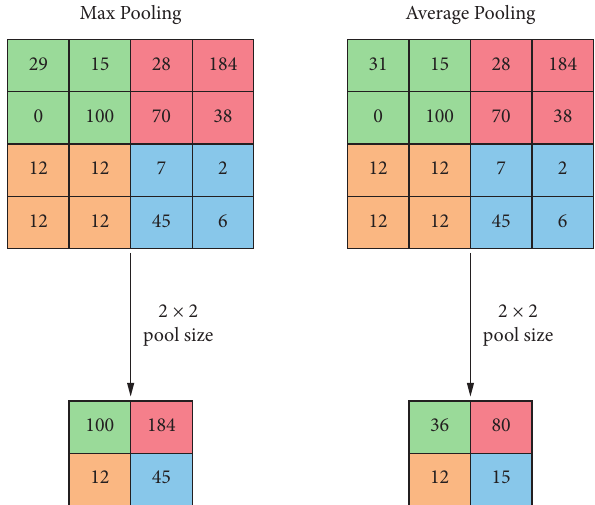
Figure 4: Pooling function with maximum clustering of left and middle right pooling